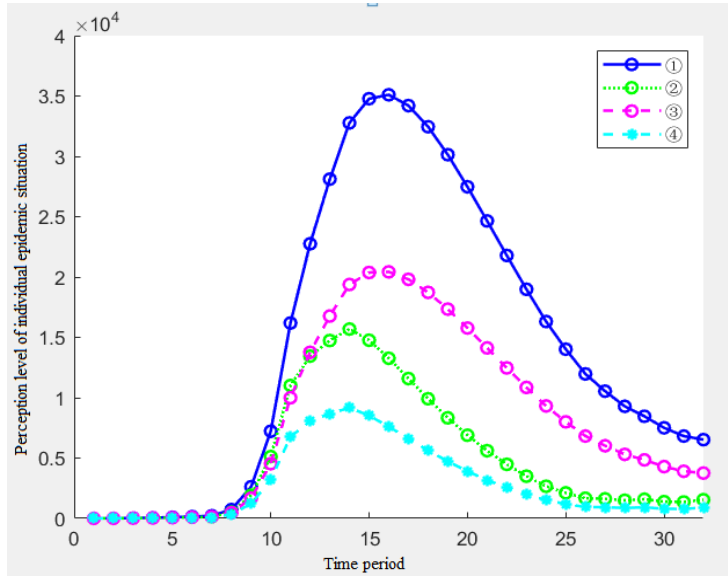
Figure 11. Assignment of the information stimulus from 27 December 2019 to 2 May 2020.